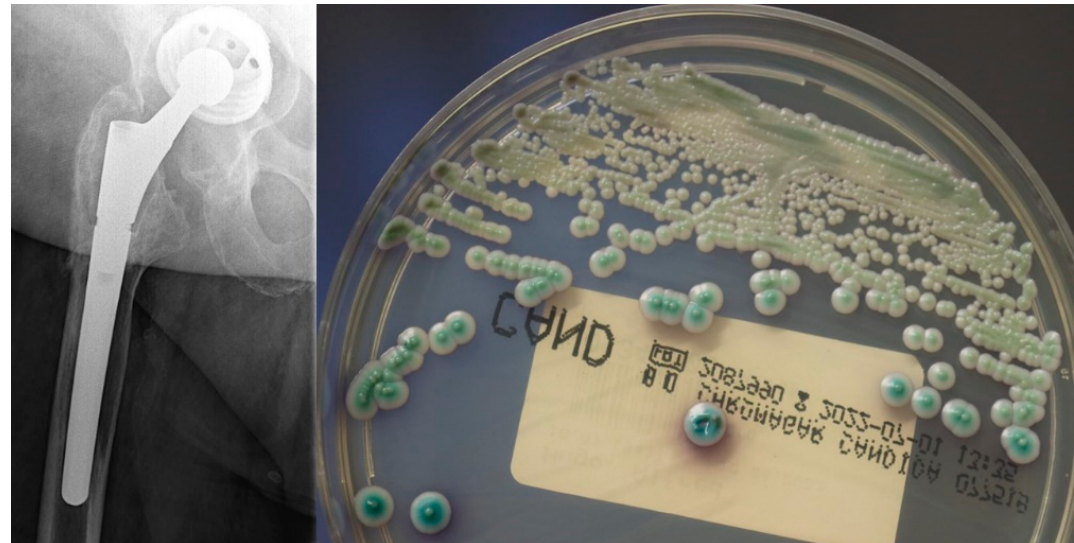
Figure 1. Left: Anterio-posterior X-rays of the right hip of a 66-year old male patient with a loosening of the acetabular cup and large osteolyses; right: the microbiological examination revealed growth of a Candida spp. isolate (here on a chromogenic agar medium).